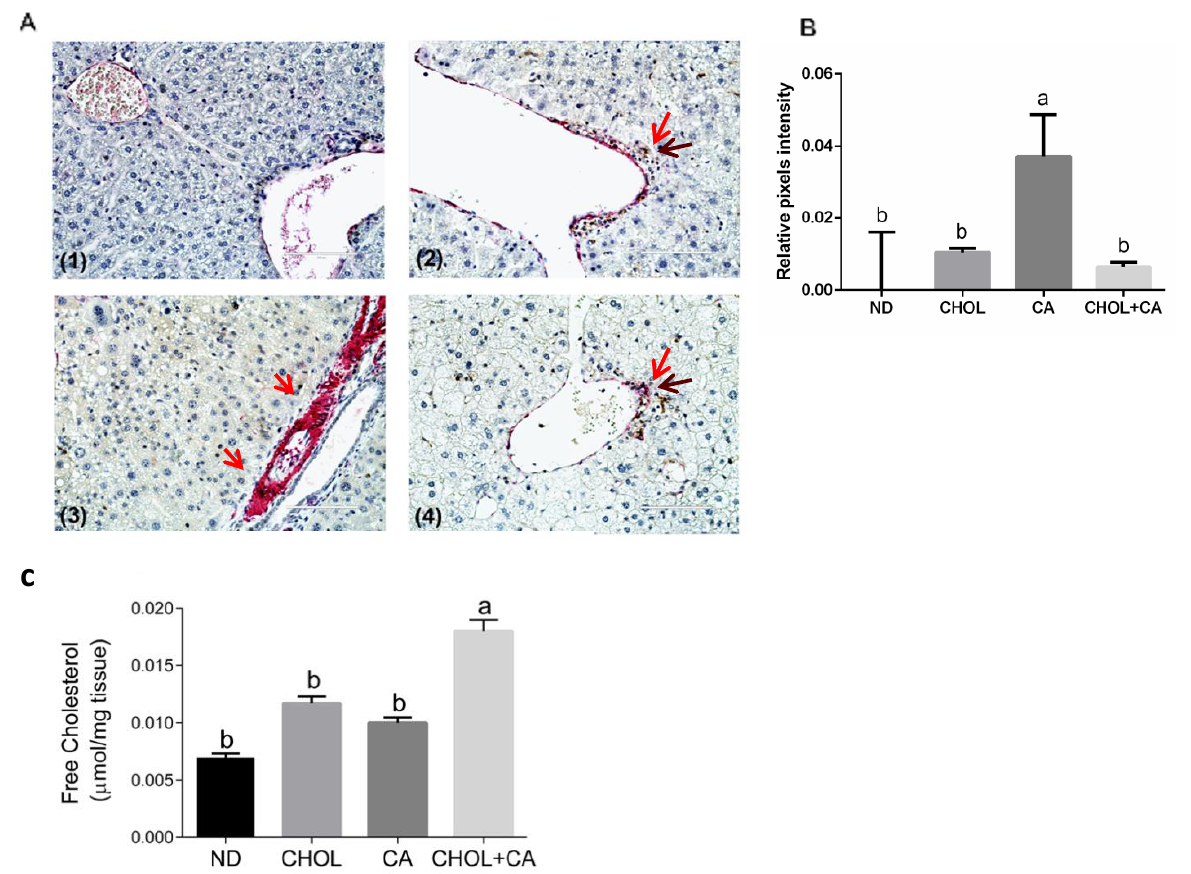
Figure 4. Dietary cholesterol and cholic acid effect on hepatic stellate cells’ apoptosis and liver tissue fibrosis. Male C57BL/6J mice aged four to five weeks were fed: ND—normal diet ( n = 10), CHOL—cholesterol diet ( n = 10), CA—cholic acid diet ( n = 9), CHOL + CA—cholesterol and cholic acid diet ( n = 8) for six weeks. ( A ) Representative histology of liver cleaved caspase- 3 (brown) and αSMA (red) sequential double immunohistochemical staining, ×40 magnification, scale bar 100 µm; dietary-induced NAFLD models of ( 1 ) ND, ( 2 ) CHOL, ( 3 ) CA and ( 4 ) CHOL + CA, with five animals in each treated group. Red arrows represent αSMA stained cells; brown arrows represent cleaved caspase-3-stained cells. ( B ) Histological sections of three individuals from each group were imaged using the EVOS M500 microscope. Two frames from each slide were captured at a magnification of ×200. All captured images were at a resolution of 2048 × 1536 pixels and saved as TIF files. ImageJ software was employed to determine the relative intensity of pixels from the red channel (red / green + blue) of the total area of each image. For graphical presentation, the average value for the relative pixel intensity of the ND group was subtracted from those of all treatments. ( C ) Levels of free cholesterol in the liver. All values are expressed as mean ± SEM. Columns indicated with different letters (a, b) are significantly different ( p < 0.05) in the Tukey-Kramer post-hoc test.